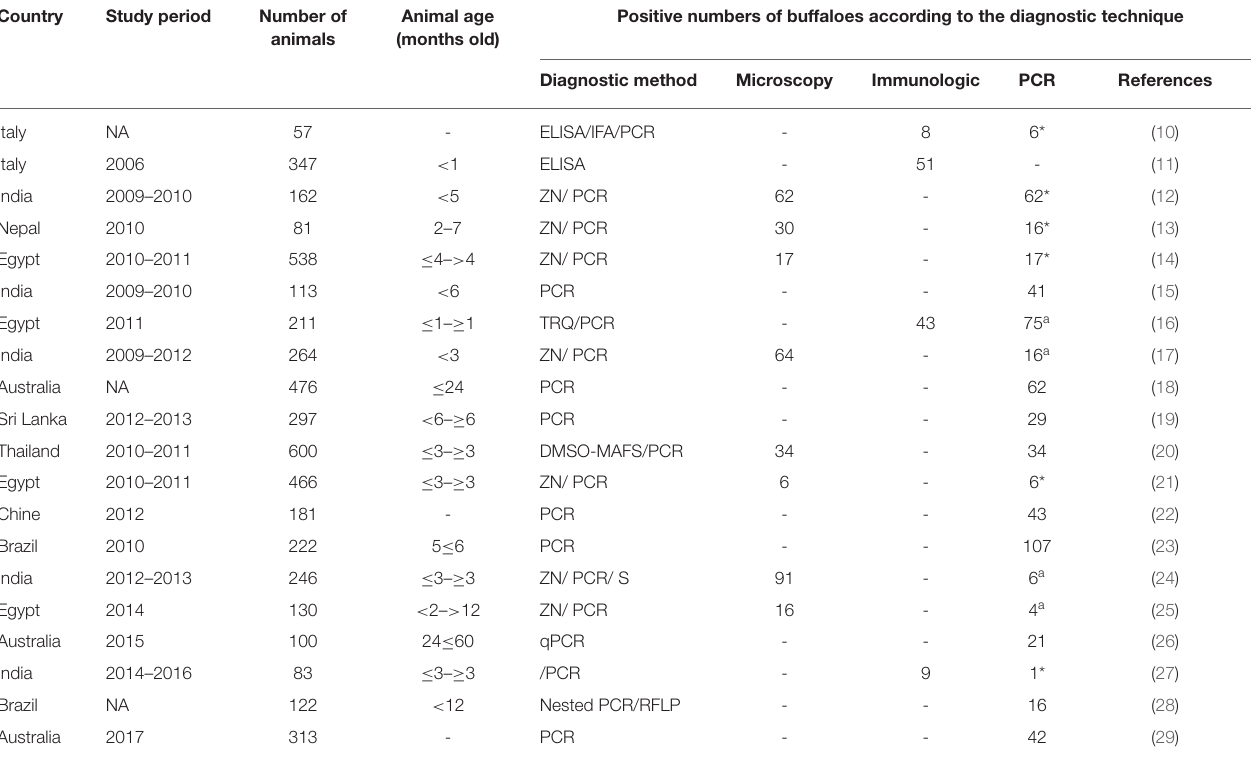
TABLE 1 | Occurrence of Cryptosporidium spp. in buffaloes worldwide using different diagnostic techniques.